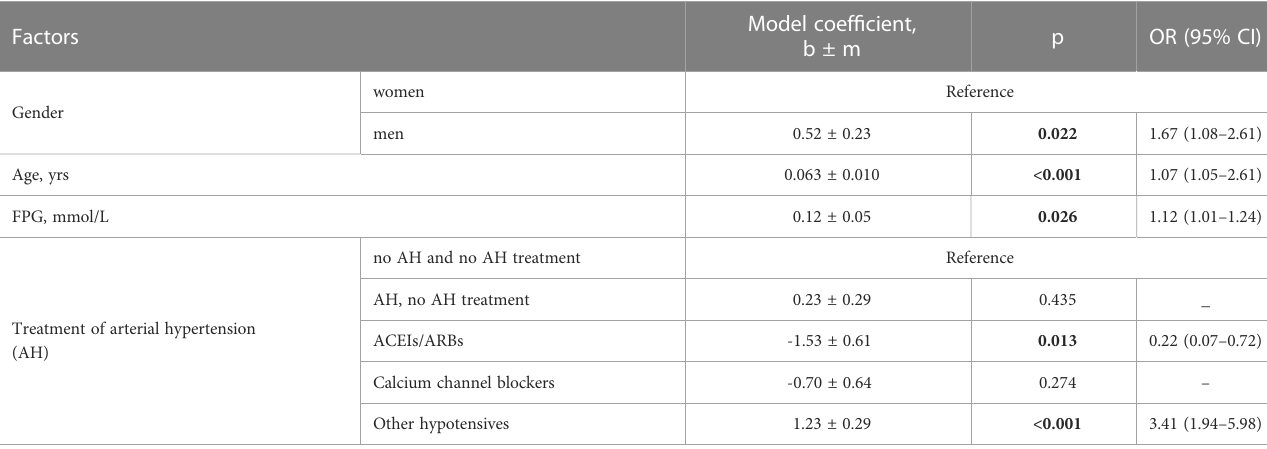
TABLE 4 Analysis of a multifactor logistic regression model for predicting the risk of death for patients without